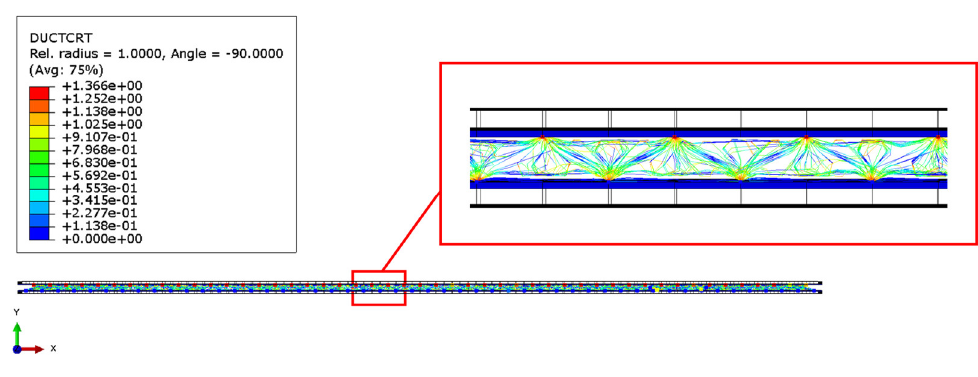
Figure 15. Fracture onset in metallic components.